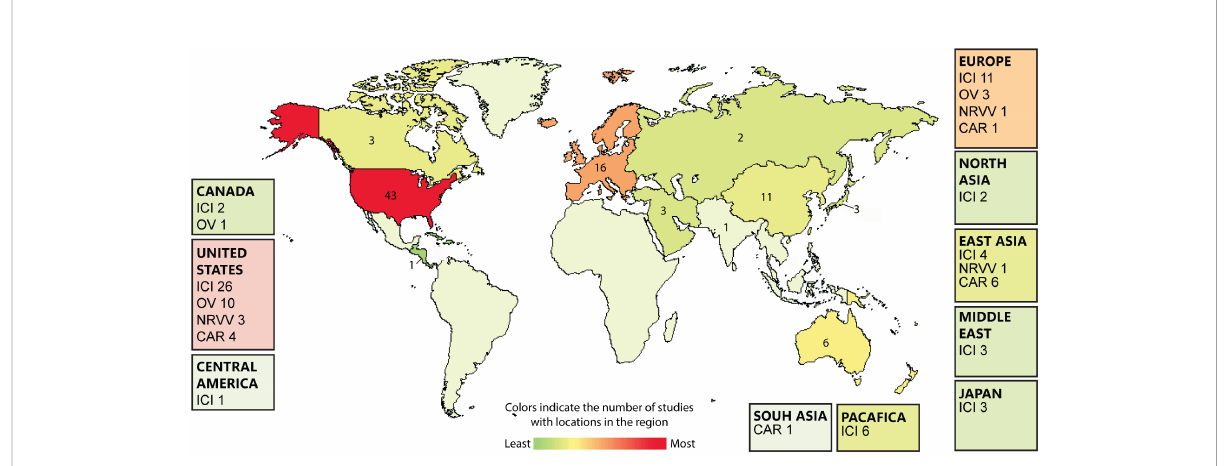
FIGURE 2 Heatmap showing the global landscape of glioblastoma (GBM) immunotherapies including; immunocheckpont inhibitors (ICI), Oncolytic virotherapy (OV), Non-replicating viral vectors (NRVV), CAR-T cell therapy (CAR). The number of GBM immunotherapies clinical trials are expressed on the country level. Data is extracted from